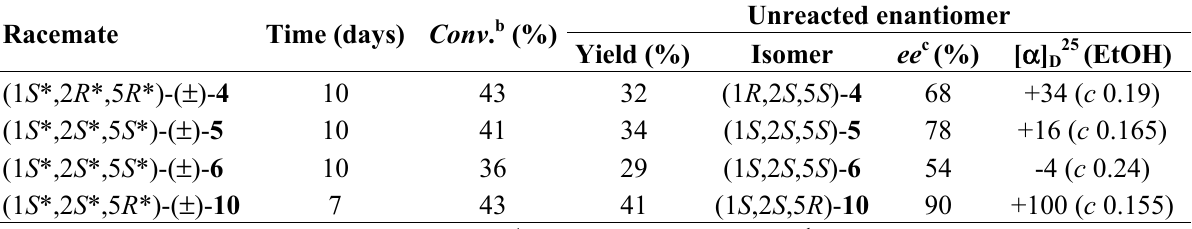
Table 2 . Lipase-catalyzed preparative-scale hydrolyses of (1 S *,2 R *,5 R *)-( ± )- 4 , (1 S *,2 S *,5 S *)-( ± )- 5 , (1 S *,2 S *,5 S *)-( ± )- 6 and (1 S *,2 S *,5 R *)-( ± )- 10 a . Unreacted enantiomer Racemate Time (days) Conv . b (%) Yield (%) Isomer ee c (%) [ α ] D25 (EtOH) (1 S *,2 R *,5 R *)-( ± )- 4 10 43 32 (1 R ,2 S ,5 S )- 4 68 +34 ( c 0.19) (1 S *,2 S *,5 S *)-( ± )- 5 10 41 34 (1 S ,2 S ,5 S )- 5 78 +16 ( c 0.165) (1 S *,2 S *,5 S *)-( ± )- 6 10 36 29 (1 S ,2 S ,5 S )- 6 54 -4 ( c 0.24) (1 S *,2 S *,5 R *)-( ± )- 10 7 43 41 (1 S ,2 S ,5 R )- 10 90 +100 ( c